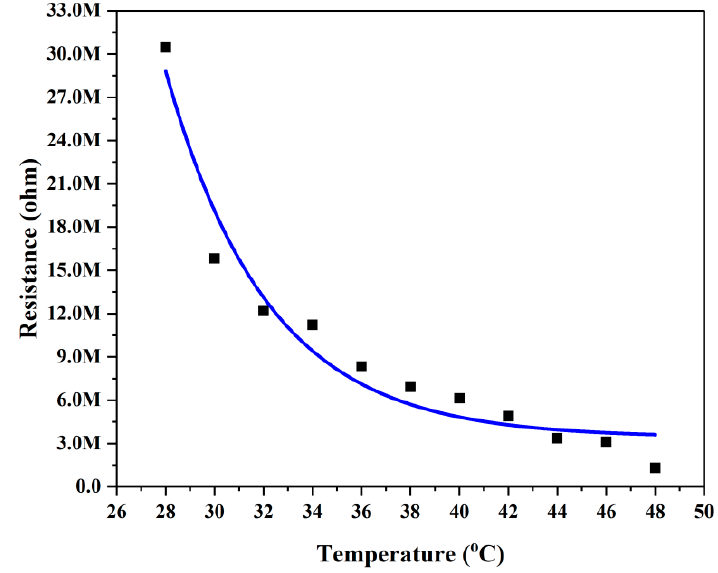
Figure 7. Role of resistance due to the increase in environmental temperature.